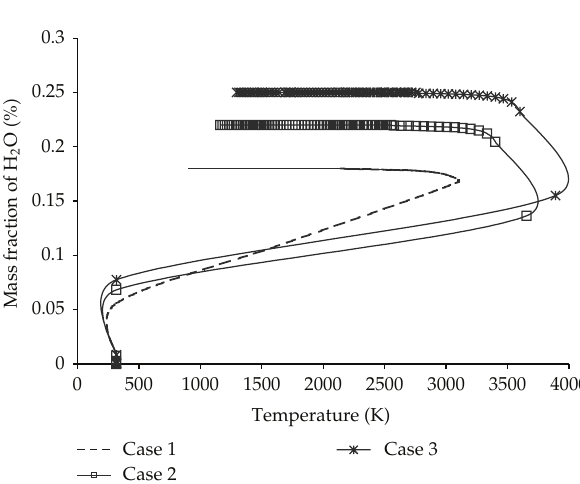
Figure 8: Mass fraction as function of temperature for each hydrogen concentration in air.